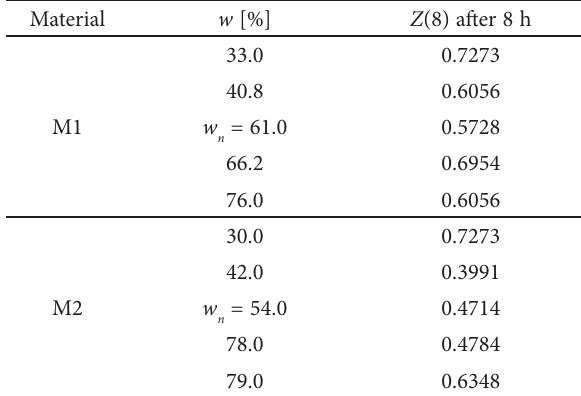
Table 5. Disintegration number Z (8) of material M1 and M2 Material